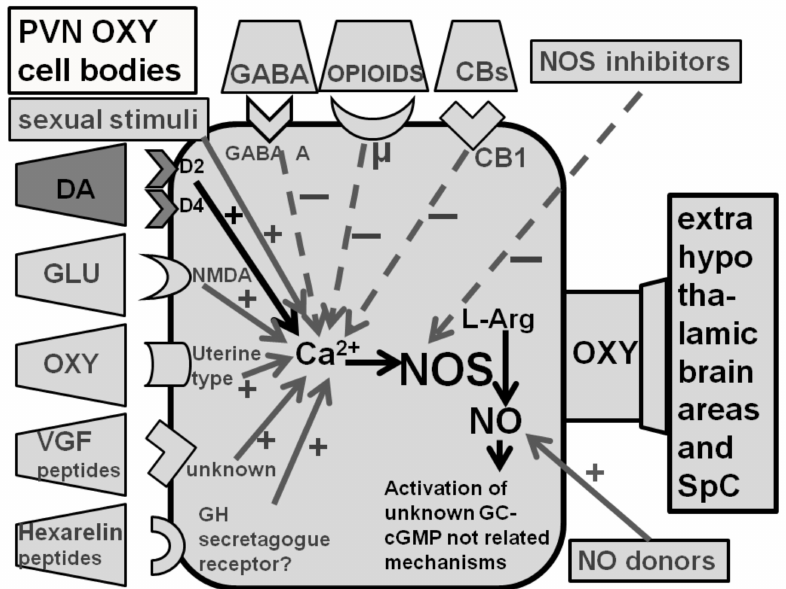
Figure 2. Dopamine facilitates penile erection by activating central oxytocinergic neurons in the PVN. The main mechanism by which dopamine and dopamine D2-like receptor agonists (D 2 and D 4 receptor subtypes) facilitate penile erection and copulatory activity is the activation of oxytocinergic neurons that originate in the paraventricular nucleus of the hypothalamus (PVN) and project to